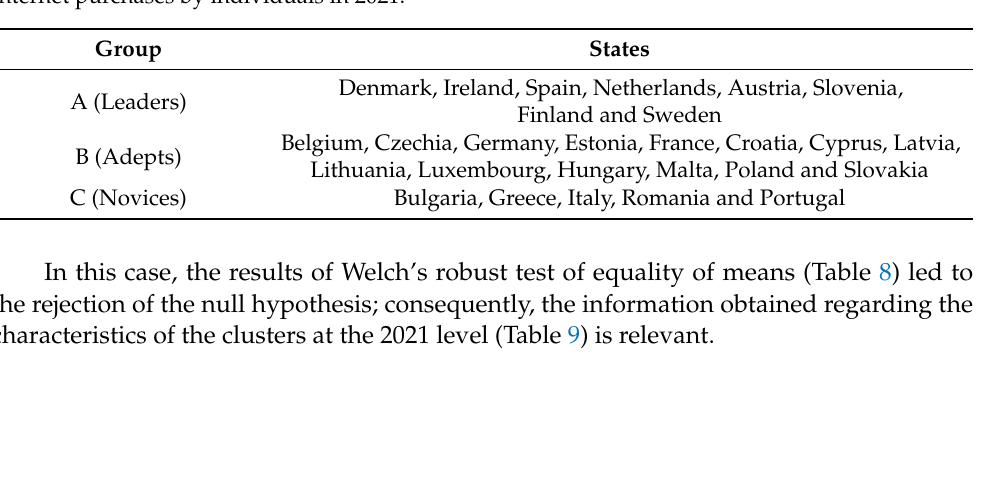
Table 7. The structure of the groups of EU member states in terms of the development level of Internet purchases by individuals in